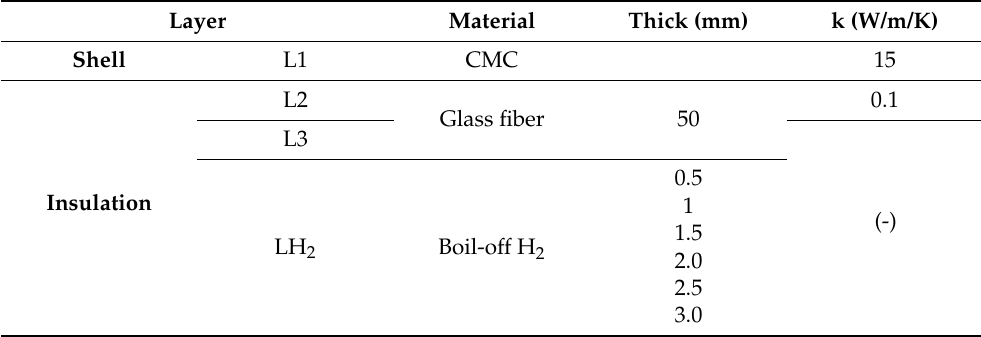
Table 3. Thicknesses and conductivities of the layers’ materials of the cabin